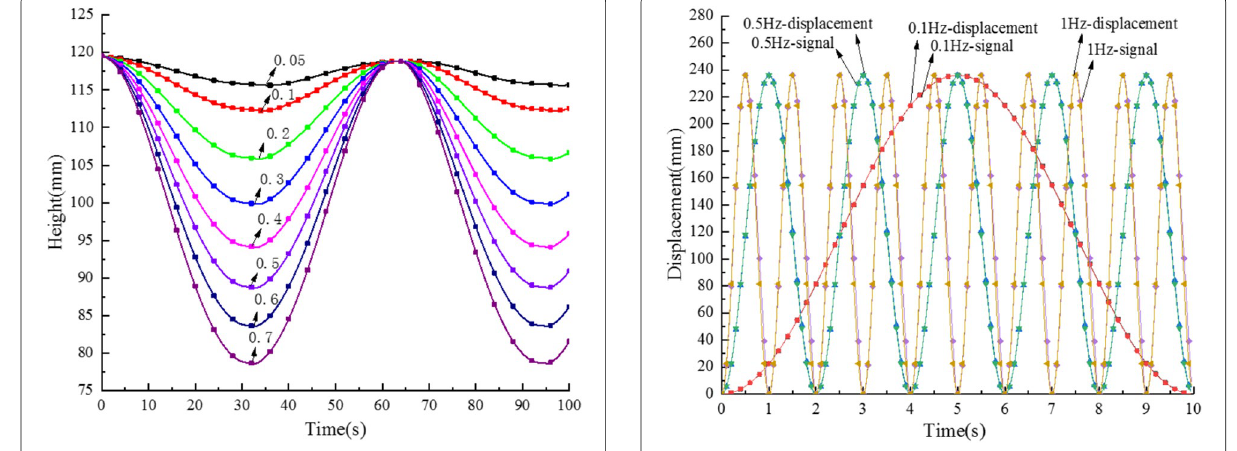
Figure 16 Displacement curves of hydraulic cylinder